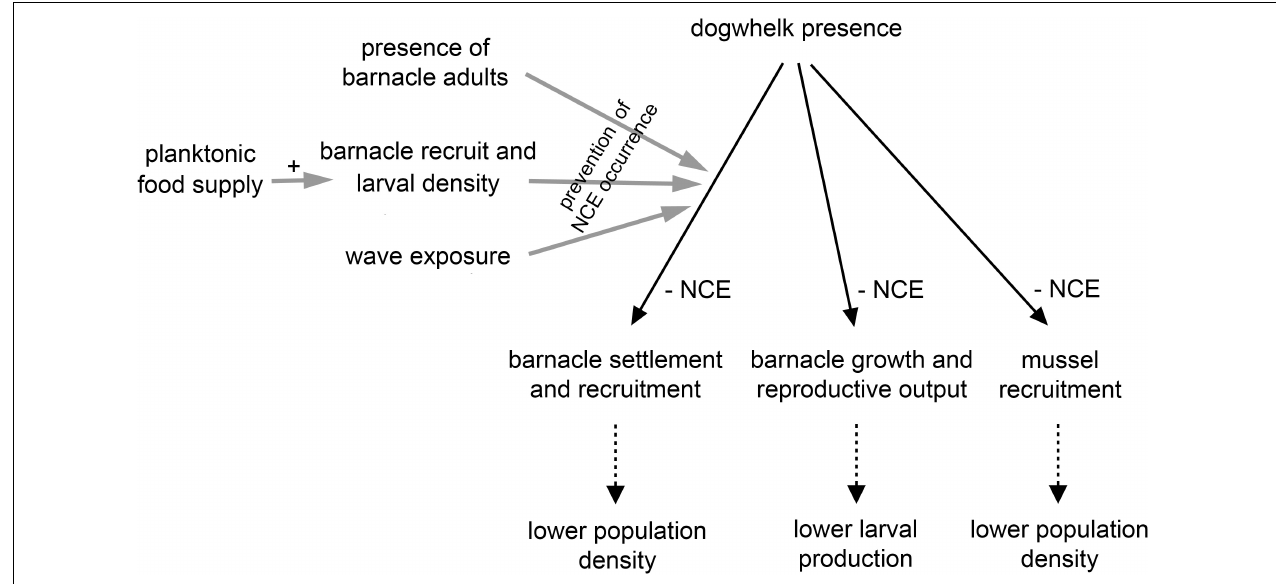
FIGURE 2 | Diagram summarising the current evidence on dogwhelk NCEs on barnacle and mussel demography supported by field experiments (solid black lines). The factors listed on the left have experimentally been shown to prevent the occurrence of such NCEs (solid grey lines). The three items depicted at the bottom represent possible additional outcomes (dotted black